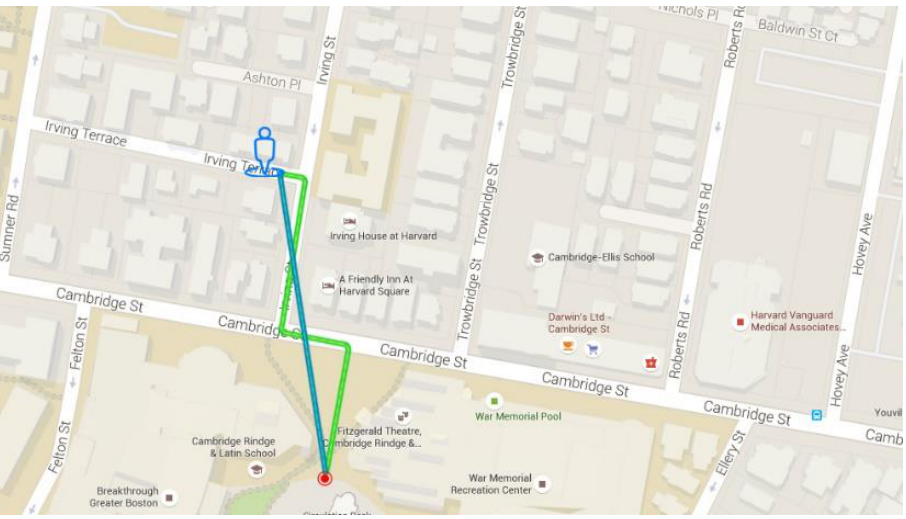
Figure 2. Moving object distance in an outdoor space.